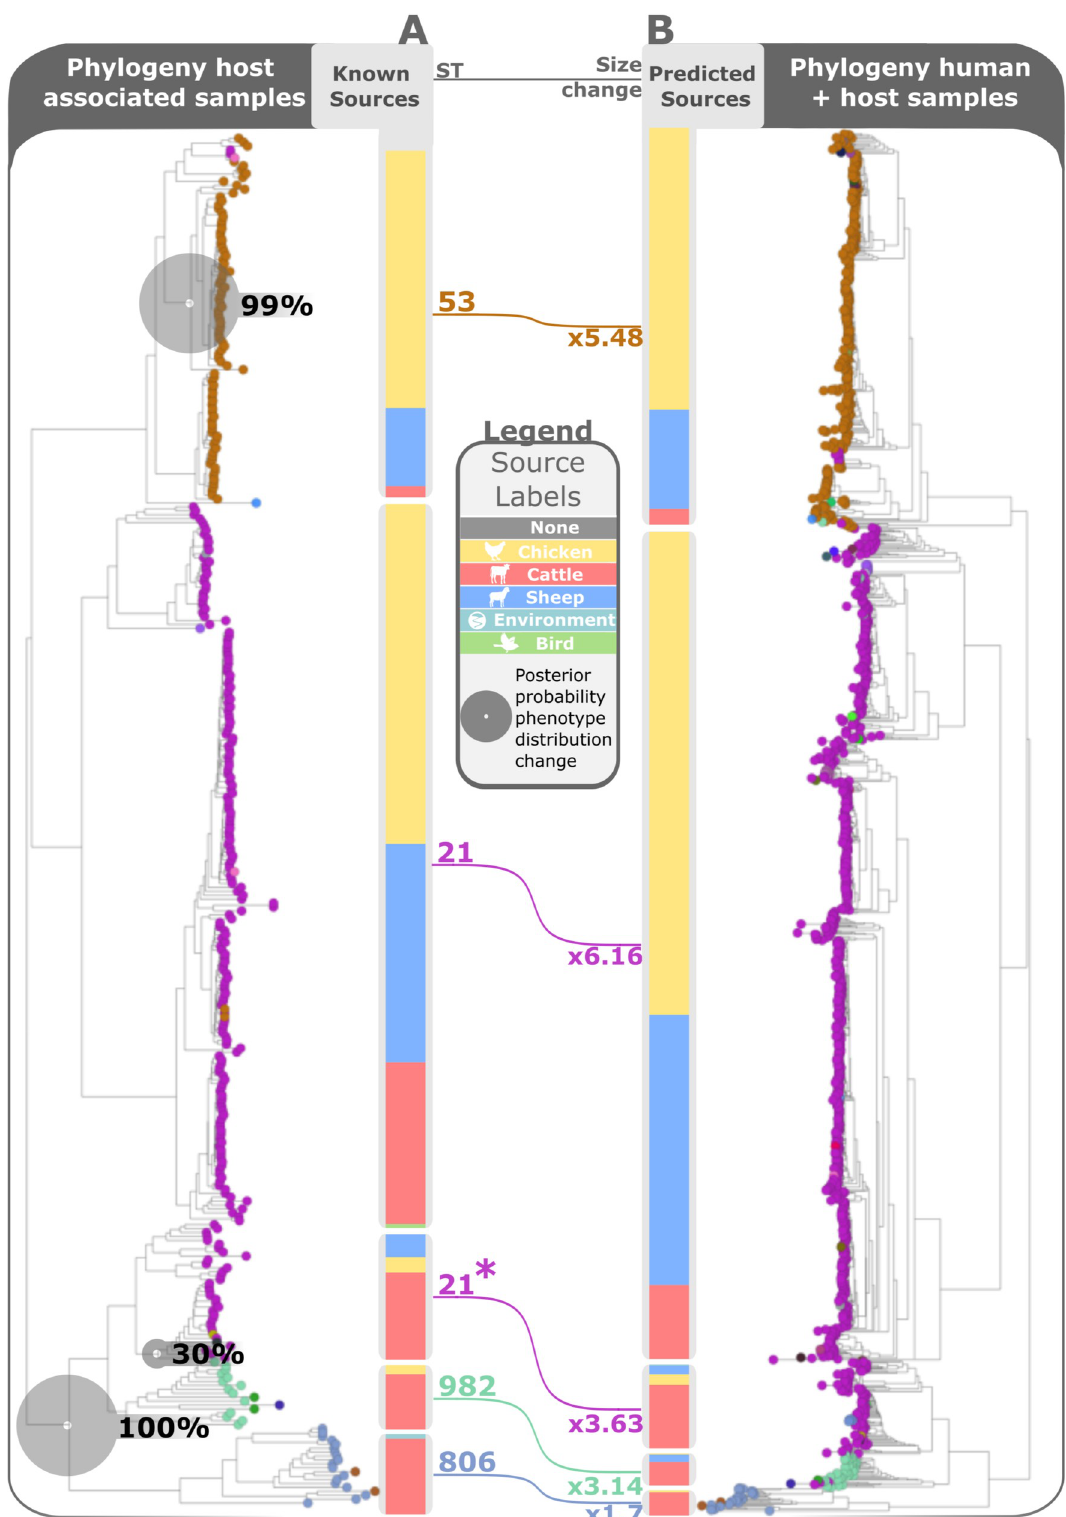
Fig 5. Phylogeny of clonal complex 21 of host animal associated samples (A) and bar charts showing the known source distribution and human samples (B) alongside the source distribution predicted by aiSource. The phylogeny is based on Neighbour joining